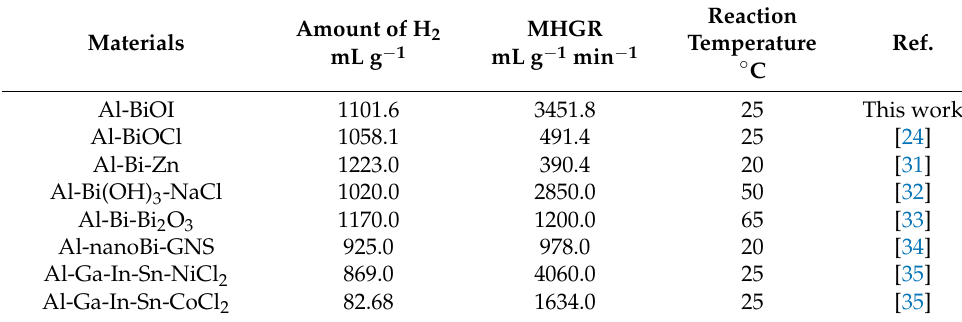
Table 5. Comparison of Al-based composites.